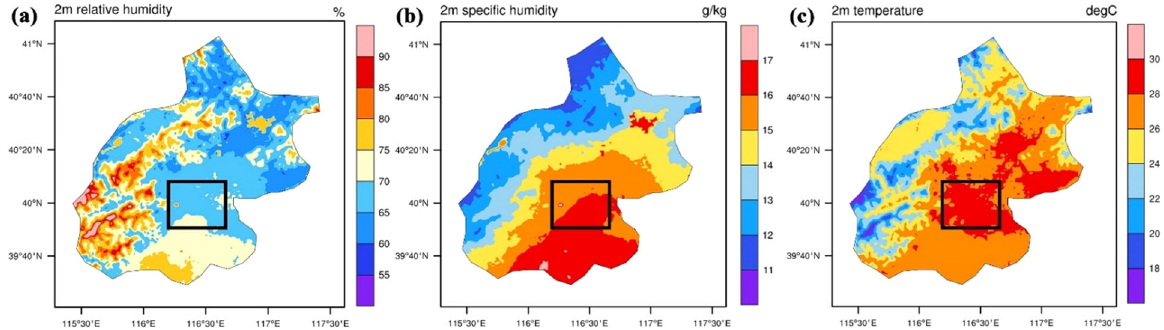
Fig. 2 Beijing experiences a dry island effect during summer. Average summer simulation results (48 h average values) for ( a ) 2 m relative humidity (%), ( b ) 2 m air speci fi c humidity (g kg − 1 ), and ( c ) 2 m air temperature